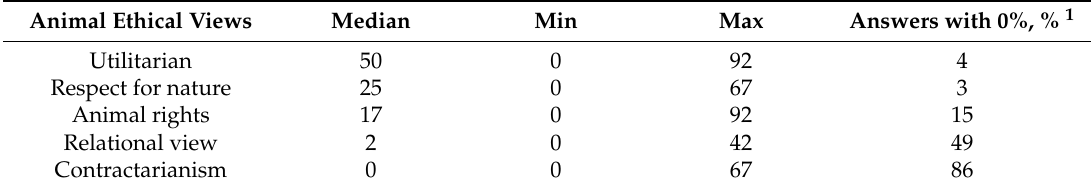
Table 2. Overall animal ethical views of Finnish veterinary students based on the Animal Ethics Dilemma ( n =